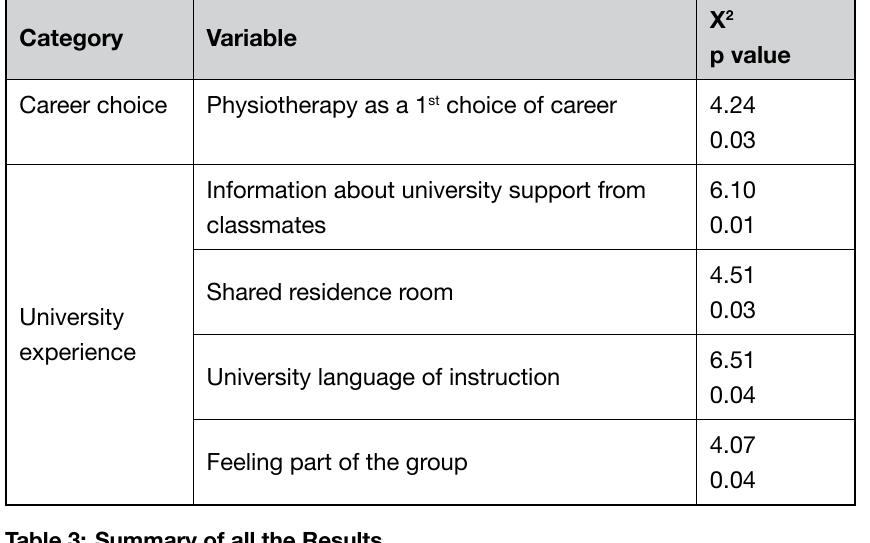
Table 3: Summary of all the Results